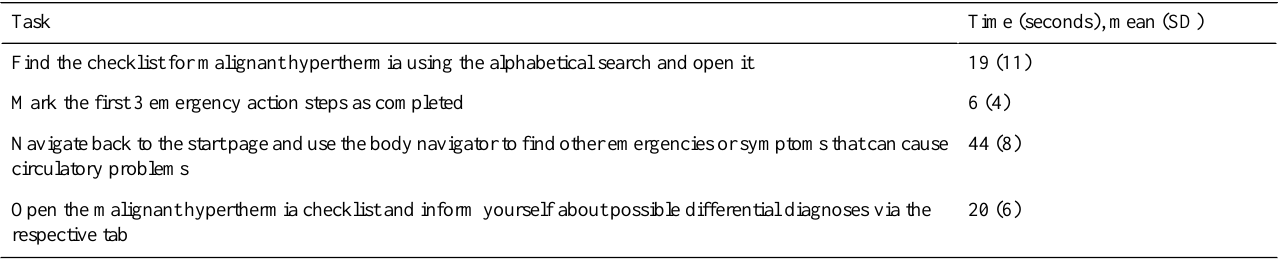
Table 1. Average time required per task during the think-aloud protocol.